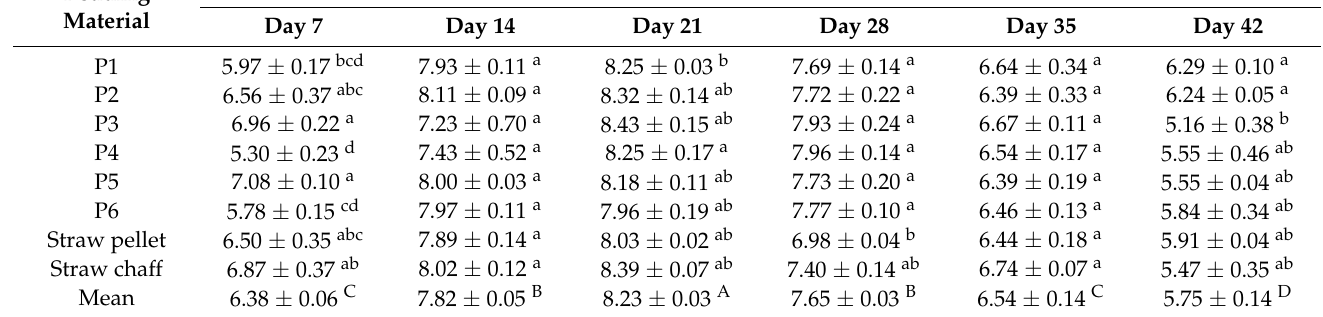
Table 7. Changes in the count of total yeast and moulds in the bedding material during use under operating conditions—1st experimental